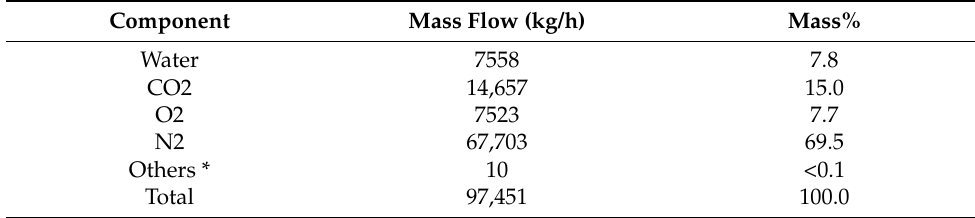
Table 2. Composition of cold flue gas